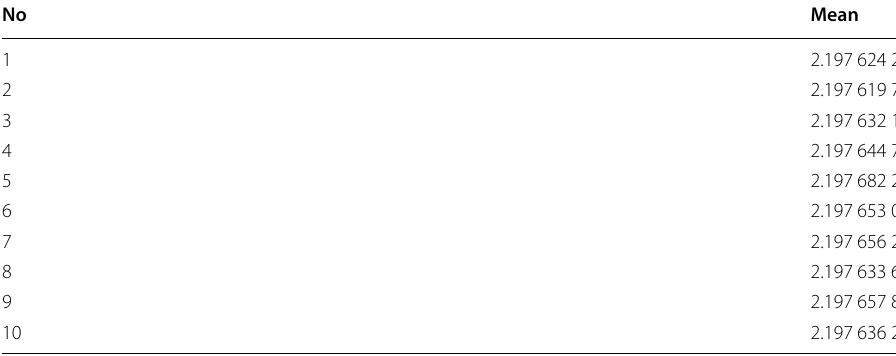
Table 4 Statistical parameter mean from a few